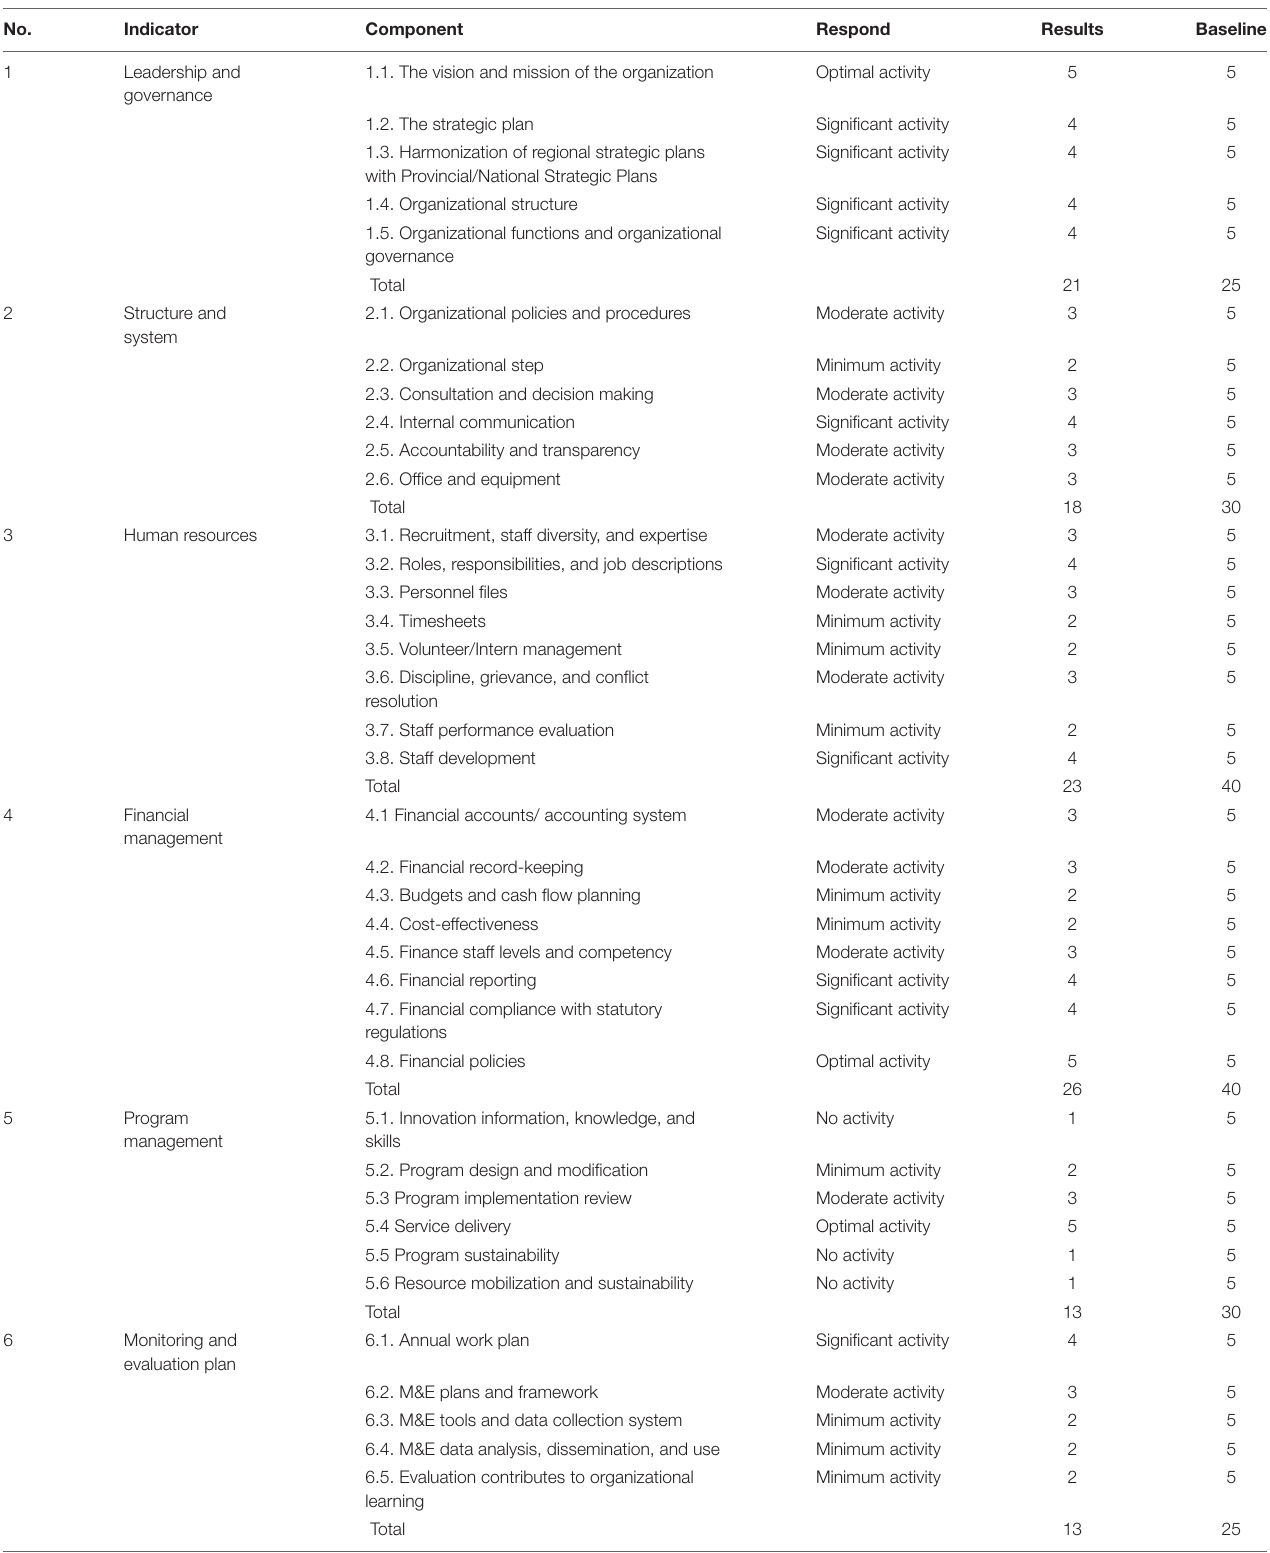
TABLE 1 | Results of measuring organizational services in regional innovation. No.